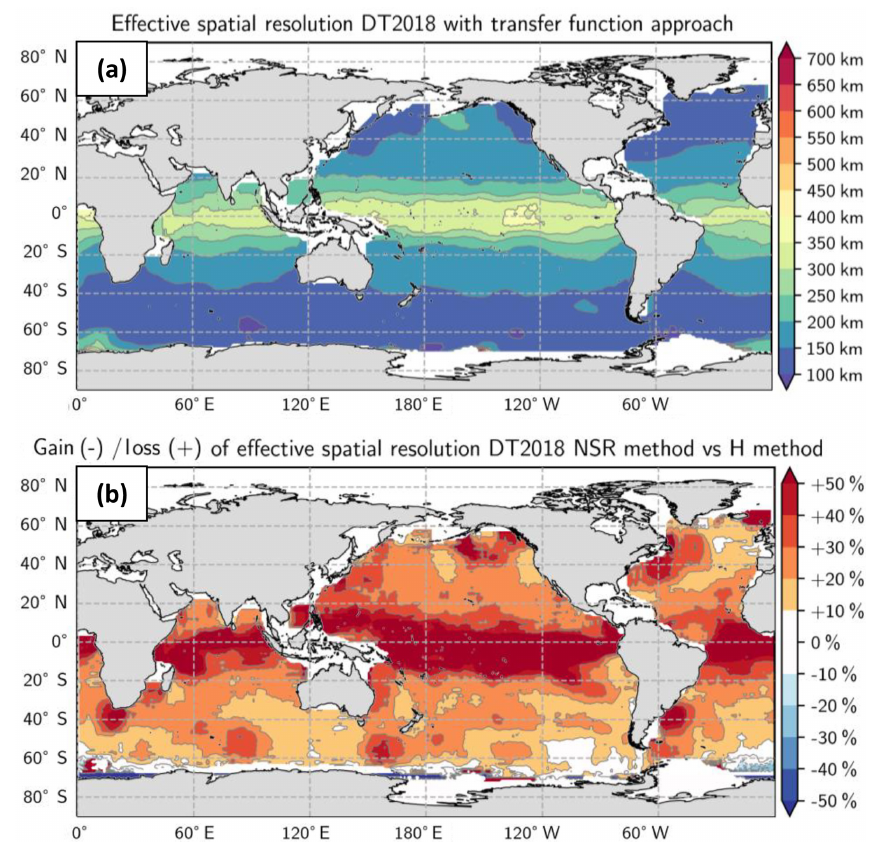
Figure A3. (a) DUACS-DT2018 resolution derived from the transfer function approach and (b) ratio of effective to transfer function resolu- tion for the DT2018 maps. Blue means finer resolution with